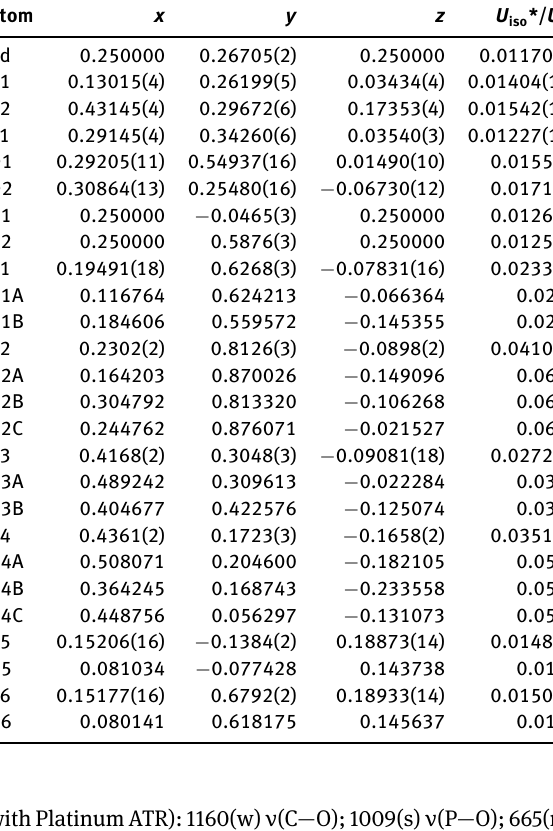
Table 2: Fractional atomic coordinates and isotropic or equivalent isotropic displacement parameters (Å 2